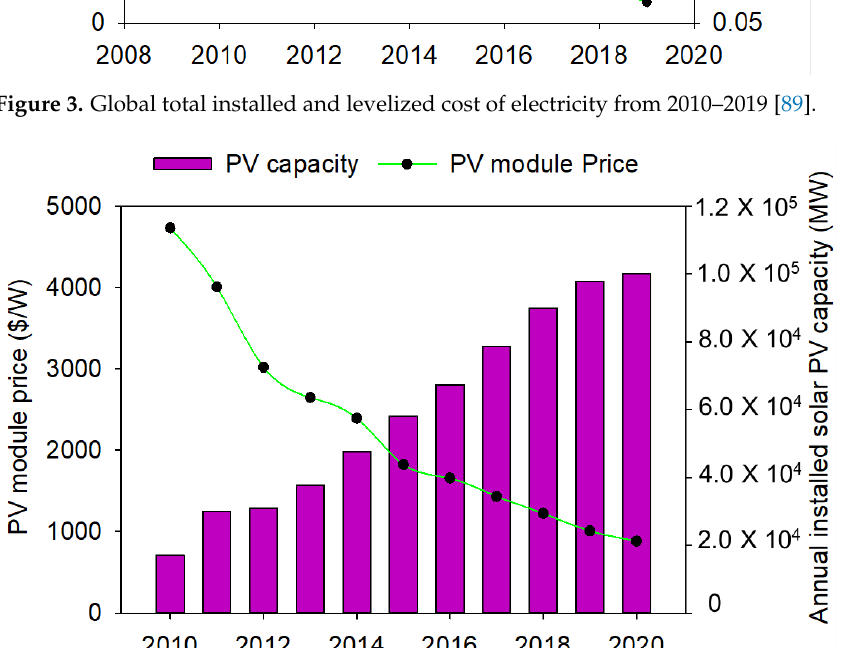
Figure 4. Solar PV installation and price from 2009 – 2020 [88].